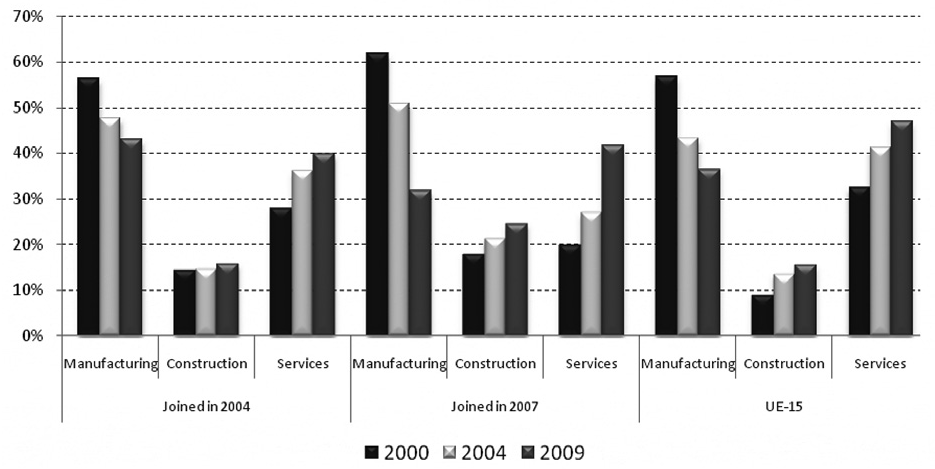
Fig. 4. Evolution of the sector distribution of ISO 9000 within the joined in 2004, joined in 2007 and EU-15 Source: Own preparation on the basis of ISO full reports of global statistics for ISO 9000 (ISO,